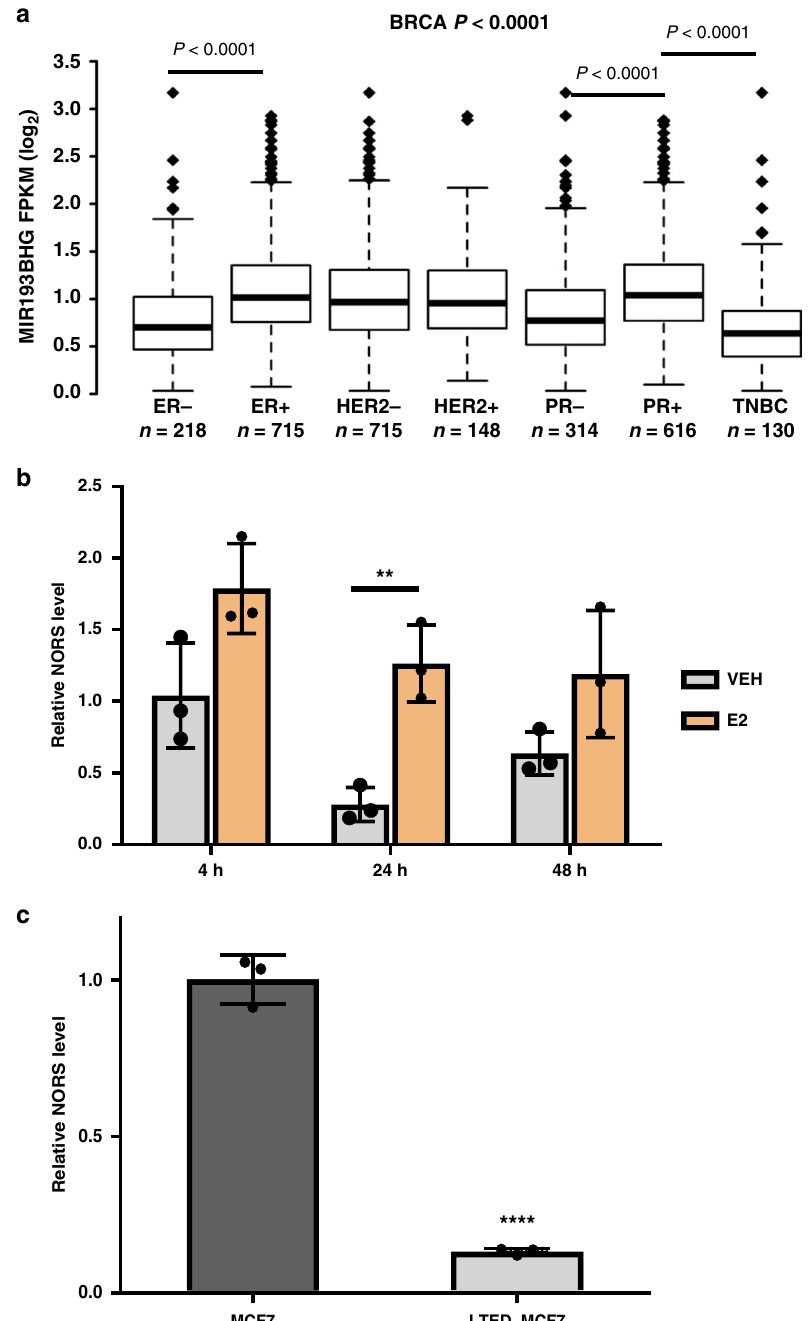
Fig. 3 lincNORS is associated with estrogen response. a lincNORS/MIR193BHG level in subtypes of breast cancer tumors in TCGA database. Boxplot represents fi rst (lower bound), median (bar inside), and third (upper bound) quartiles, whiskers represent 1.5 times the interquartile range. Kruskal – Wallis test followed by Dunn ’ s multiple comparison test. b qPCR analysis of lincNORS in MCF-7 cells treated with 10 nM E2 or vehicle control for the indicated time. Data are shown as mean ± SD from three biological replicates (** p = 0.004, two-sided Student ’ s t -test). c qPCR analysis of lincNORS level in MCF-7 and long-term estrogen-deprived MCF7 cells. Data are shown as mean ± SD from three biological replicates (**** p < 0.0001, two-sided Student ’ s t Fig. 10c, d). Consistent evidence was observed in MDA-MB-231 while miR-193b expression remained unchanged (Fig. 5f). Steroid xenografts with stably suppressed or overexpressed lincNORS . Knockdown resulted in increased metastatic load, whereas stable overexpression had the opposite effect (Fig. 5d, e). However, lincNORS status in xenografts did not signi fi cantly affect primary tumor size (Supplementary Fig. 10e). The effect of shRNA on lincNORS expression was still detectable in the harvested tumors,